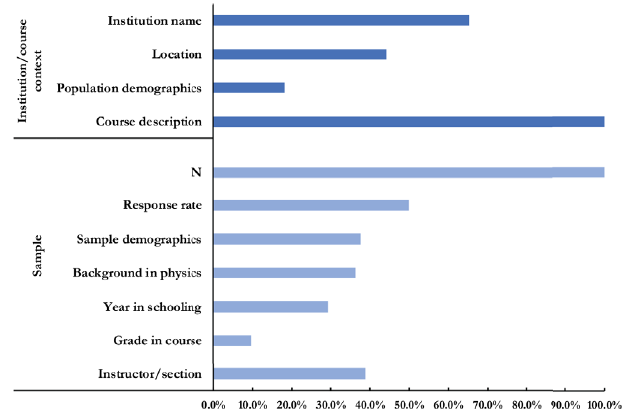
FIG. 1. Percentage of manuscripts that had specific population and sample codes.